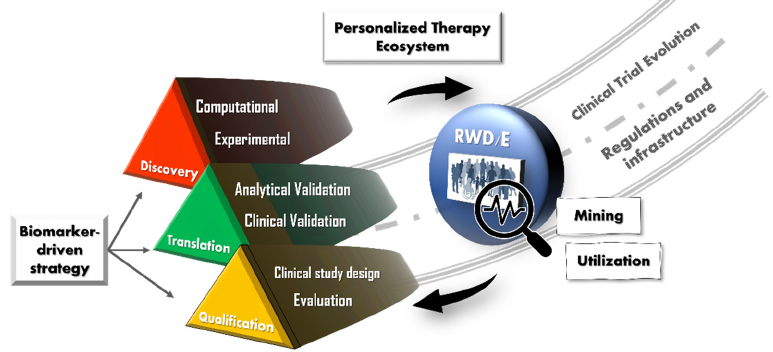
Figure 2. Roadmap for biomarker-driven drug development for personalized